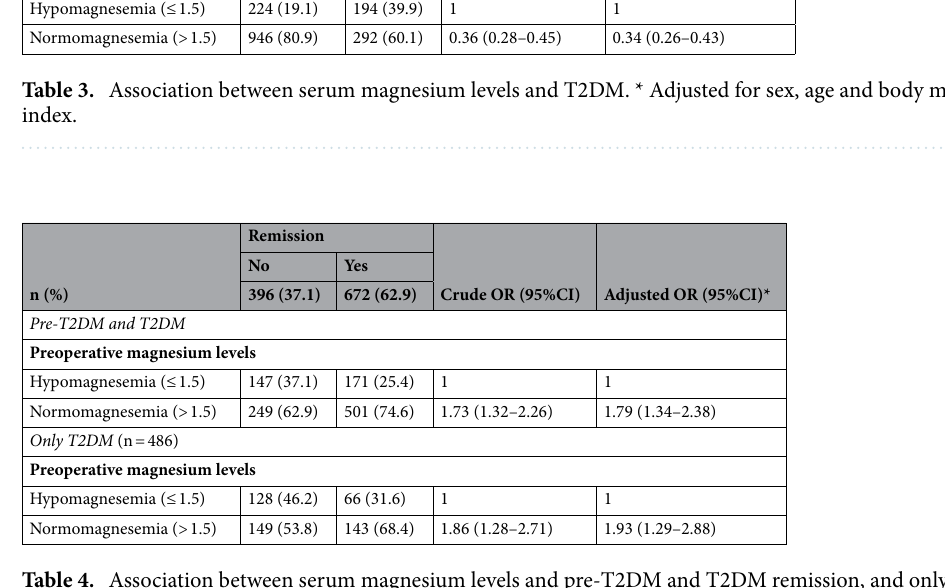
T2DM (95%CI)*No n (%) Crude OR (95%CI) Adjusted OR